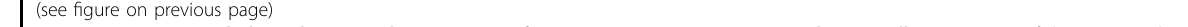
Fig. 2 Long-term psychological stress induces storage of “ epigenetic memory ” in paternal germ cells. a Heatmap of the DMRs in the F 0 generation. b Heatmap of the DMRs in the F 1 generation. c Heatmap of the DMRs in the F 2 generation. d Trend in DMRs across generations after removal of the original stimulus – psychological stress. e Distribution of the Δβ values (changes in DNA methylation levels of the DMRs) across generations. f Distribution of the stress-induced F 0 DMRs at the gene level. g Distribution of the functional genes related to DMRs. h Enrichment of F 0 -DMRs related genes to the phenotype-associated genes from mouse genome information (MGI) database. i Gene Ontology (GO) analysis of genes related to F